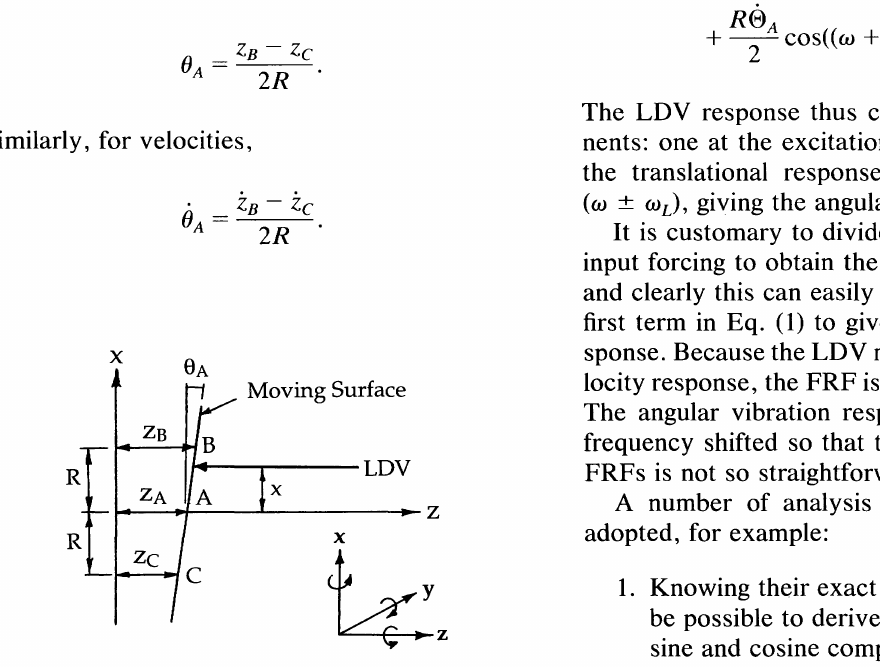
FIGURE 1 Displacement of a Moving